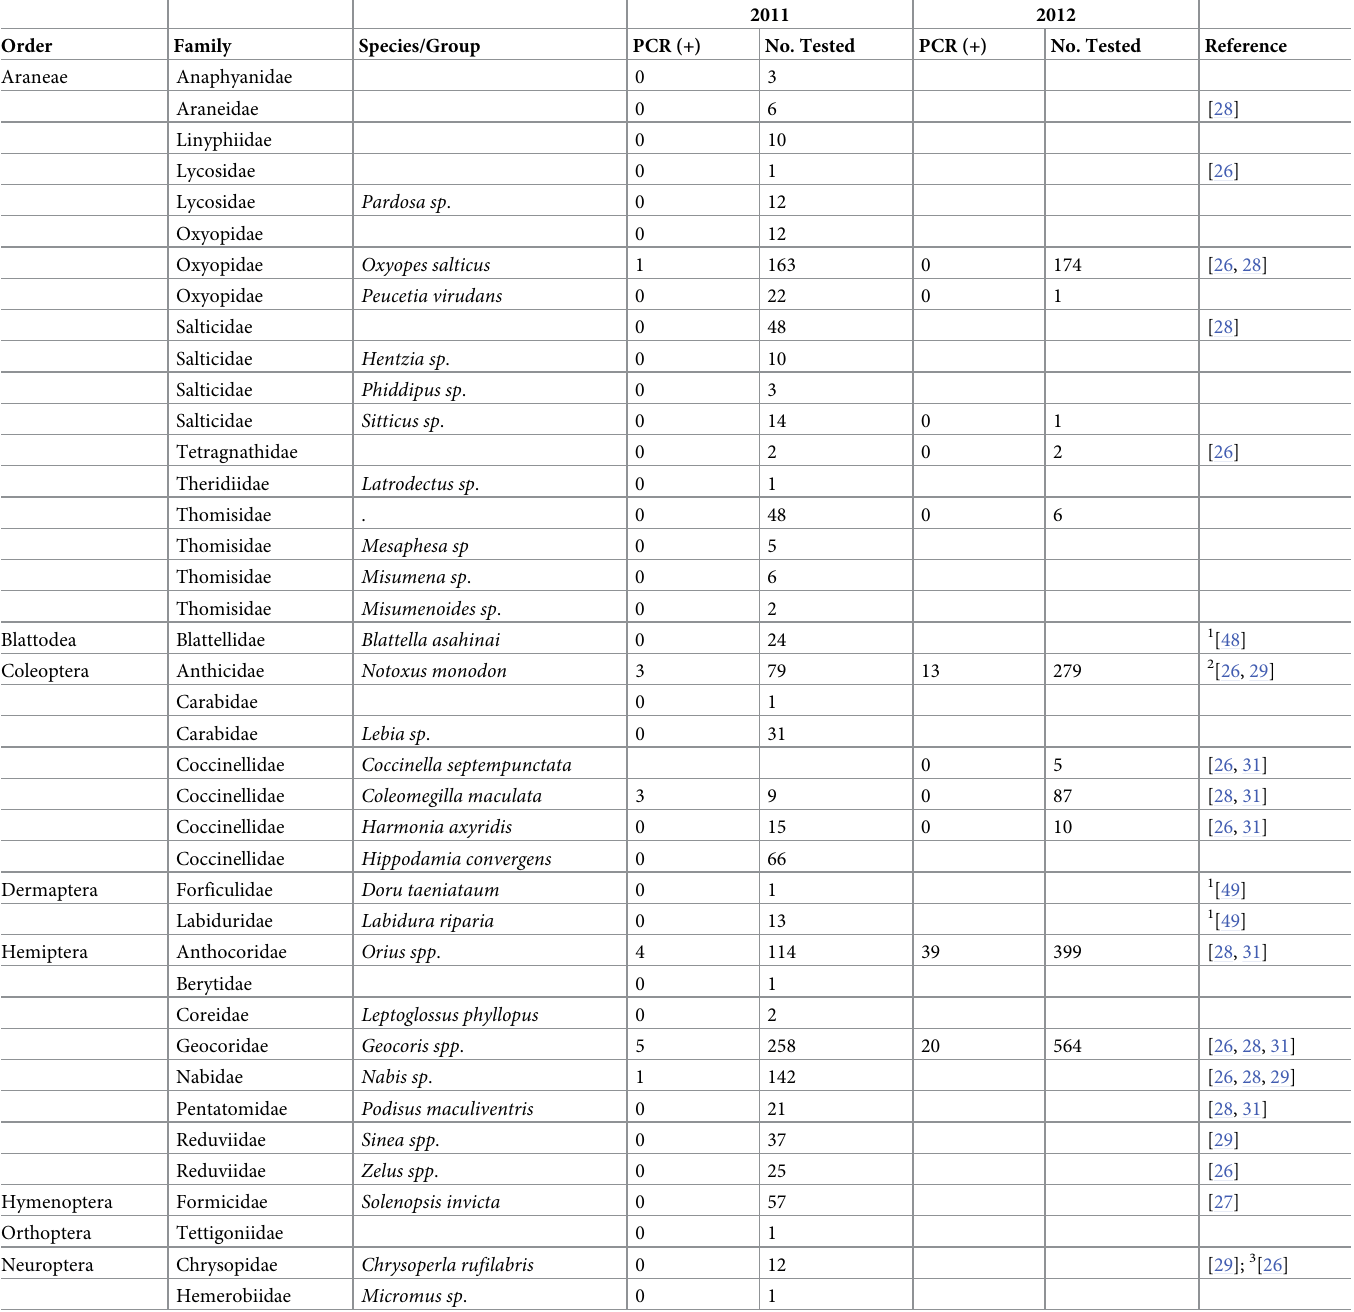
Table 2. List of all predator taxa tested, with numbers testing positive for N . viridula in PCR